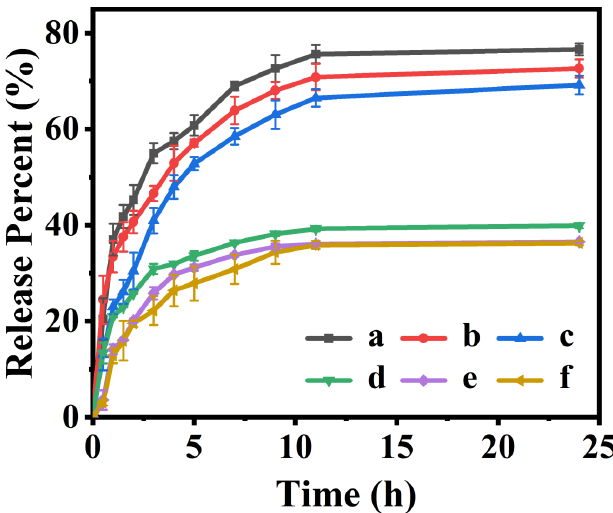
Figure 9. Cumulative IBU-releasing profiles from drug-loaded P(NA-AA)−0−y at 37.0 °C under pH 2.0 (y = 0.1 (a), 1.0 (b), and 10.0 (c)) and 7.4 (y = 0.1 (d), 1.0 (e), and 10.0 (f)).